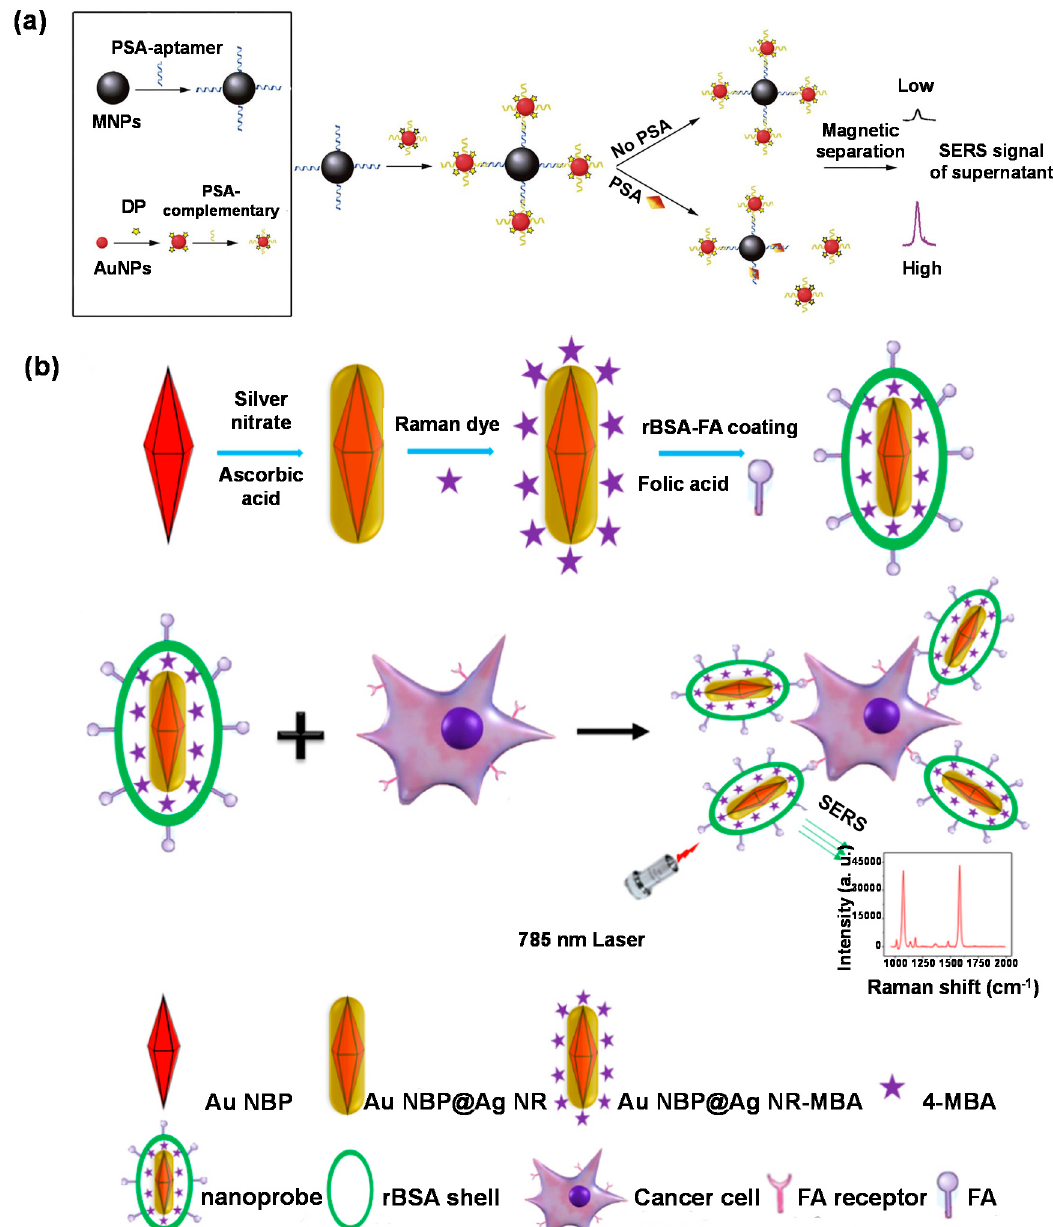
Figure 11. ( a ) Sandwich-type aptasensor for PSA detection with MNPs and AuNPs [233]; ( b ) SERS-based bioimaging of cancer cells [236]. Abbreviations: Ag NR: Silver nanorods; Au NBP: Gold nanobipyramid; AuNP: Gold nanoparticle; DP: 4,4’-dipyridyl; FA: Folic acid; MBA: 4-mercaptobenzoic acid; rBSA: Reduced bovine serum albumin; SERS: Surface enhanced Raman scattering. Reproduced with permission from [233,236].